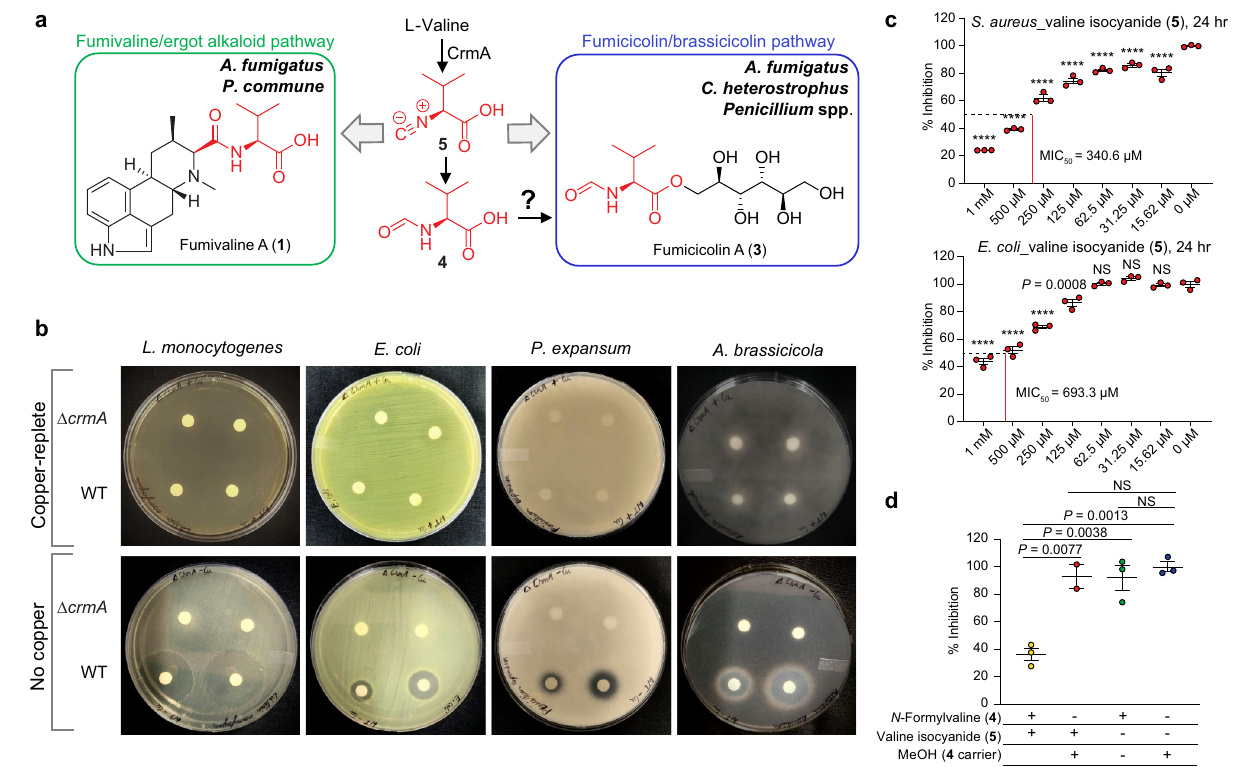
Fig.4|PutativebiosynthesisofCrmA-derivedmetabolitesindiversefungiand antimicrobial activities. a Fumivaline biosynthesis was observed in A. fumigatus and P. commune , which has the ergot alkaloid BGC and a homolog for crmA , whereasfumicicolinbiosynthesiswasobservedin A.fumigatus , Penicillium spp.and C. heterostrophus , all of which harbor crmA homologs. b Growth of Listeria mono- cytogenes, Escherichia coli , Pencillium expansum , and Alternaria brassicicola is inhibited when challenged with extracts from WT but not Δ crmA A. fumigatus grown without copper supplementation. Extracts from copper supplemented cultures do not inhibit microbial growth. c Valine isocyanide ( 5 ) signi fi cantly